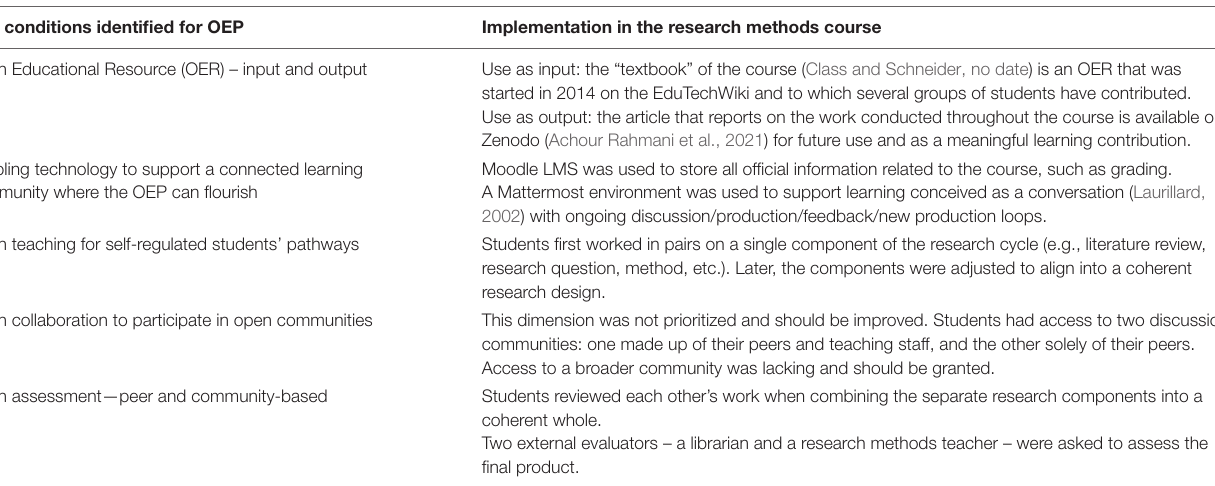
TABLE 3 | Implementation of the five OEP conditions in a qualitative research method course at the master’s